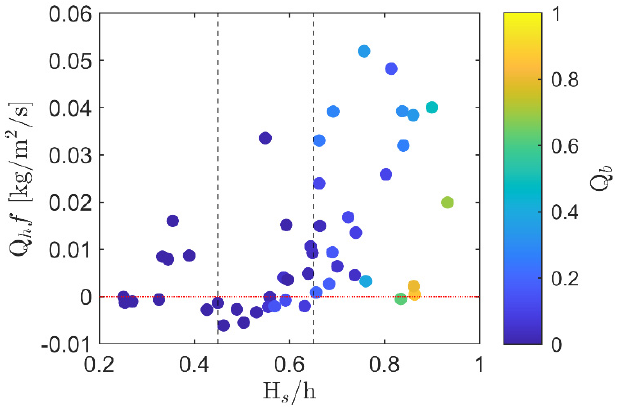
Figure 19. Wave-driven high-frequency suspended sediment transport, Q hf (cumulated over three sensors in the vertical) plotted against relative wave height, H s /h . The colors indicate the fraction of broken waves in the time series ( Q b ). Positive Q hf is onshore directed. Reproduced from Brinkkemper et al. [93].